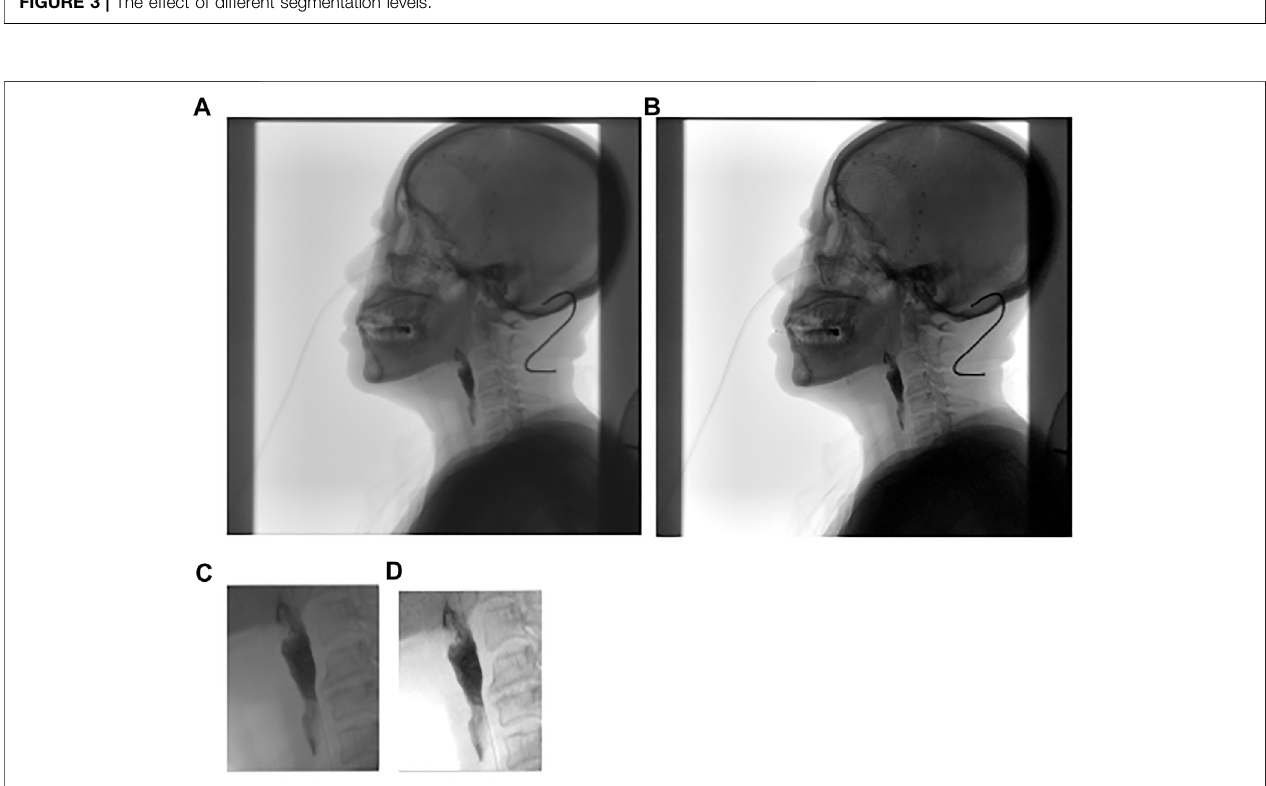
FIGURE 4 | (A) is the original image; (B) is global contrast stretching; (C) is part of (A) and (D) is local contrast stretching.